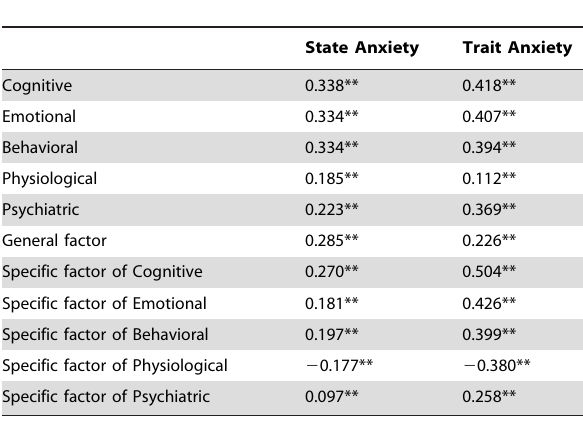
Table 6. Correlations between State/trait Anxiety and ASRS Results Under CTT and Bifactor